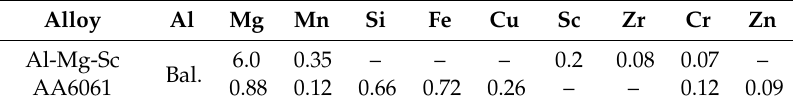
Table 1. Measured chemical composition of program materials